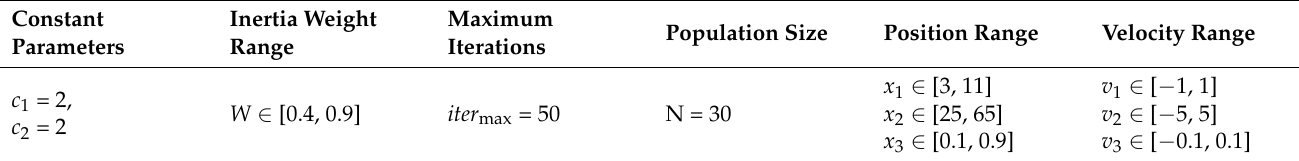
Table 3. Intelligent optimization and COMSOL optimization